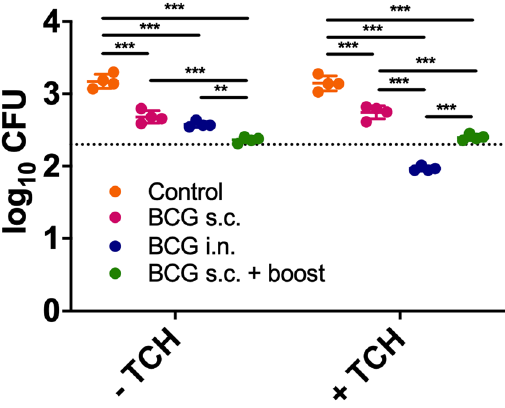
Figure 3. Optimised ex vivo MGIA comparing MTB Erdman growth inhibition conferred by vaccination in murine lung. C57BL/6 mice (n = 6/group) received s.c. or i.n. BCG Pasteur Aeras at week 0, s.c. BCG Pasteur Aeras at week 0 and i.n. boosting with the candidate vaccine spore-FP1 at week 3, or received no treatment (control). At six weeks, 1 × 10 6 lung cells were co-cultured with 200 CFU MTB Erdman in 48-well plates. At 96 hours, samples were transferred to the BACTEC MGIT system until TTP values were generated. Mycobacterial quantification was performed in the presence and absence of TCH. TTP values were converted to log 10 CFU based on a standard curve. Data points (n = 4/group) represent samples generated from pooled cells isolated from six mice. Dotted line indicates mycobacterial input at day 0. Statistical significance was tested by one-way ANOVA followed by Tukey’s multiple comparison test. Error bars represent mean ± standard deviation. * p < 0.05 (adjusted); ** p < 0.01 (adjusted); *** p < 0.001 (adjusted). ANOVA, analysis of variance; BCG, Bacille Calmette-Guérin; CFU, colony-forming units; i.n., intranasal; MGIA, mycobacterial growth inhibition assay; MGIT, mycobacterial growth indicator tube; s.c., subcutaneous; TCH, 2-thiophenecarboxylic acid hydrazide; TTP, time to